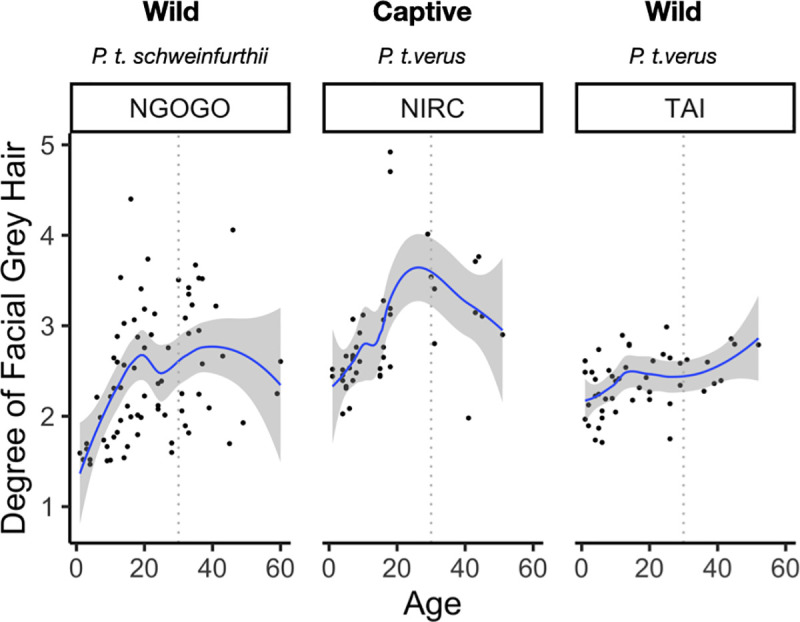
Plot of facial hair greying scores against age, fit with a smoothed line showing standard error of the regression line (i.e., grey shading).The dashed line indicates 'mid-life' for individuals in our sample (here, 30 years of age), illustrating the degree of greying does not progressively increase after this time point.